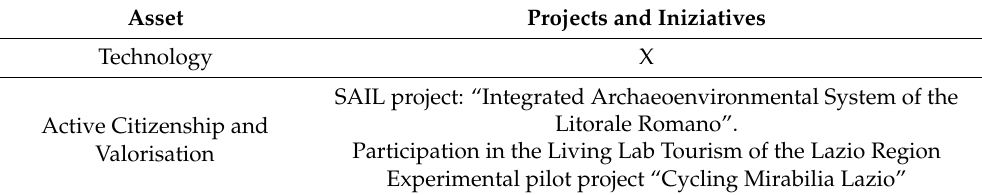
Table 4. Cont. Asset Projects and Iniziatives